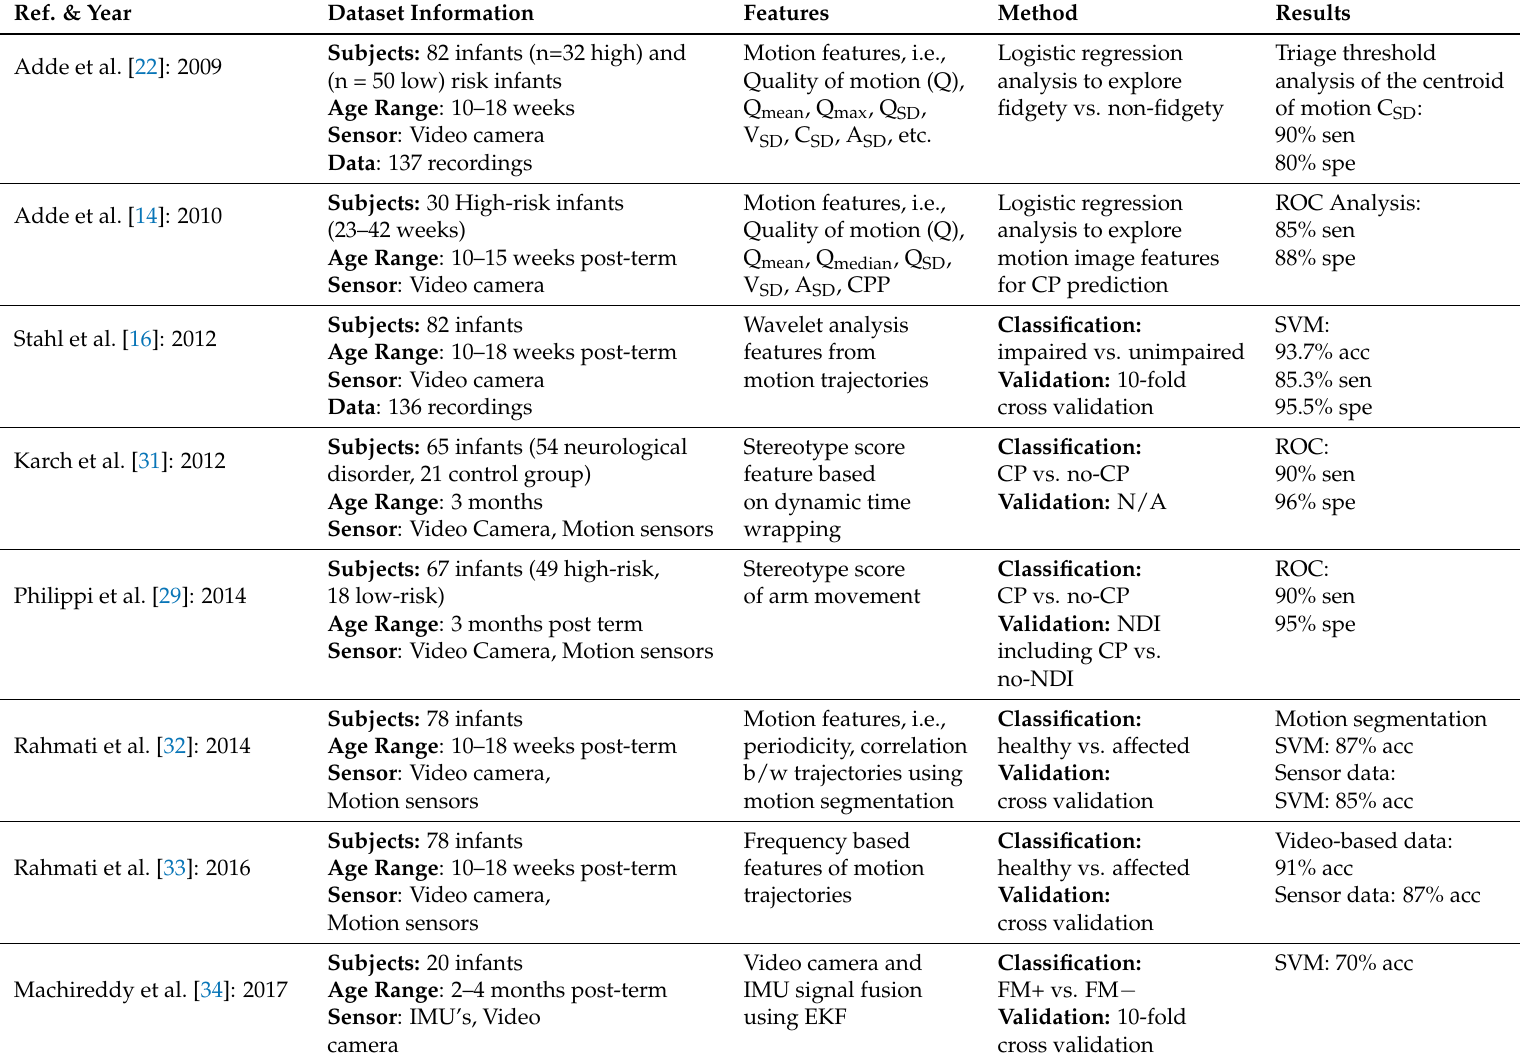
Table 5. Classification results of fidgety movements (FMs)